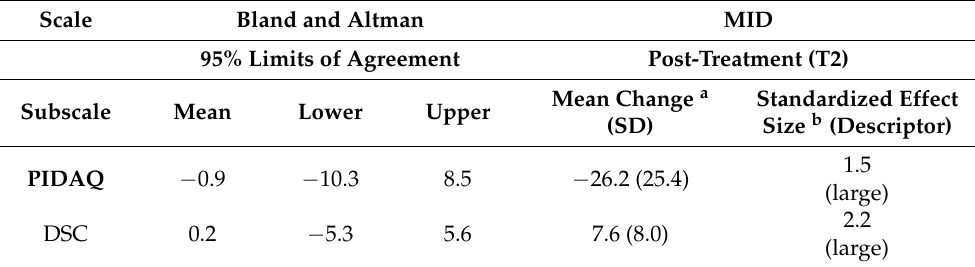
Table 6. The minimal important differences (MID) of the Malaysian psychosocial impact of dental aesthetics questionnaire (PIDAQ) and dental self-confidence (DSC) subscale after orthodontic